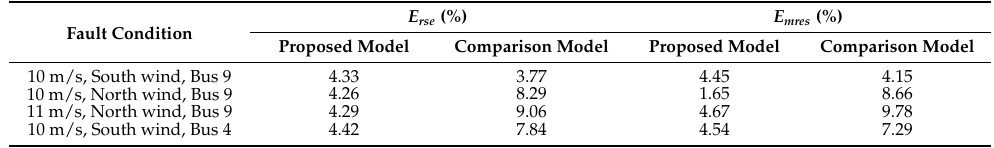
Table 6. E rse and E mres of voltage in PCC.